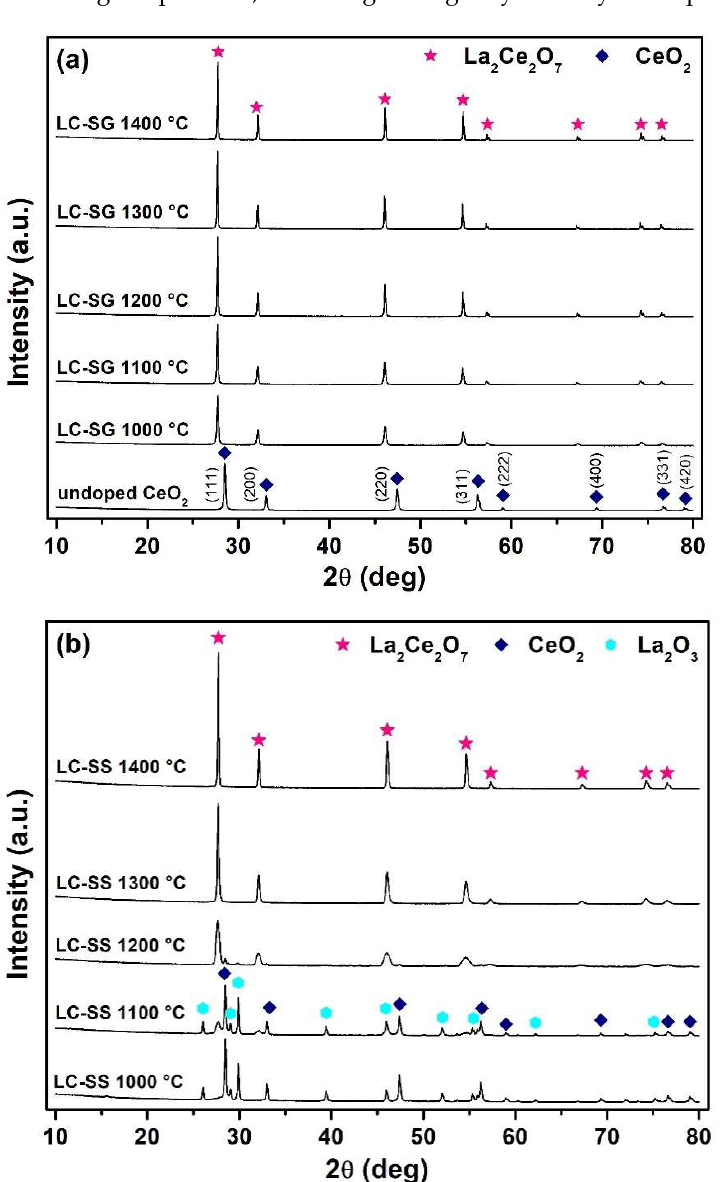
Figure 3. XRD patterns of the LC powders calcined at different temperatures: ( a ) LC-SG and ( b ) LC-